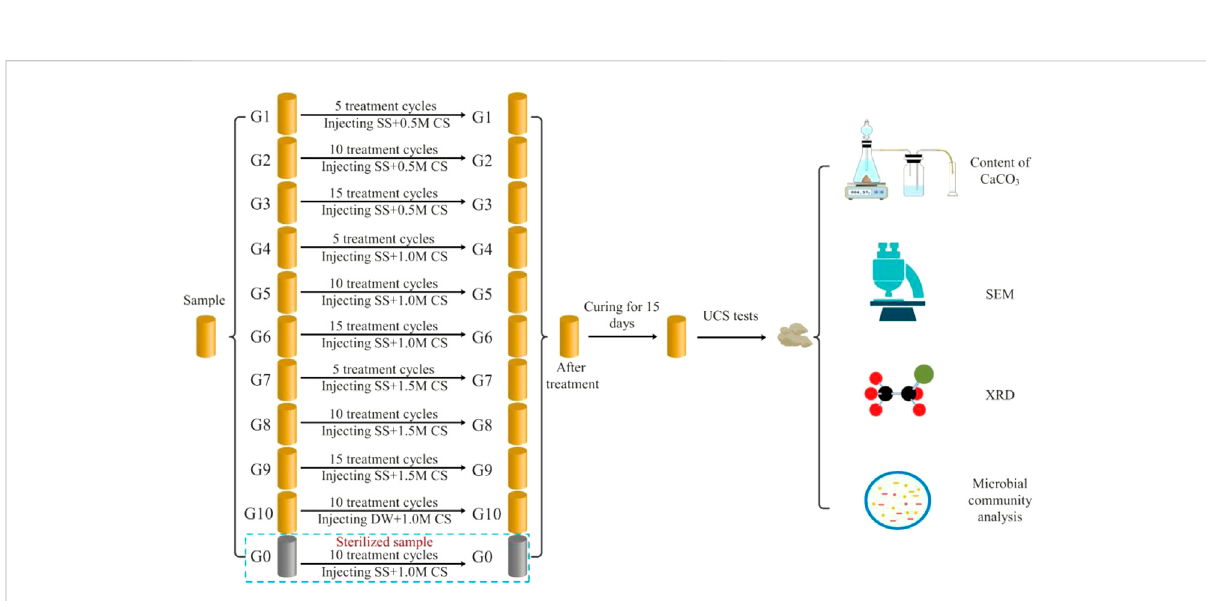
FIGURE 4 Schematic of the test procedures (SS — stimulation solution; CS — cementation solution; DW — deionized